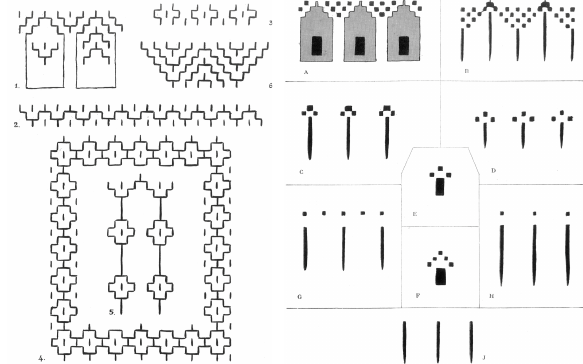
Figure 2. Left: Decorative motifs in Kelaat M’Gouna. Right: Progressive simplification of a frieze with arches. Source: Jacques-Meunié, 1962.